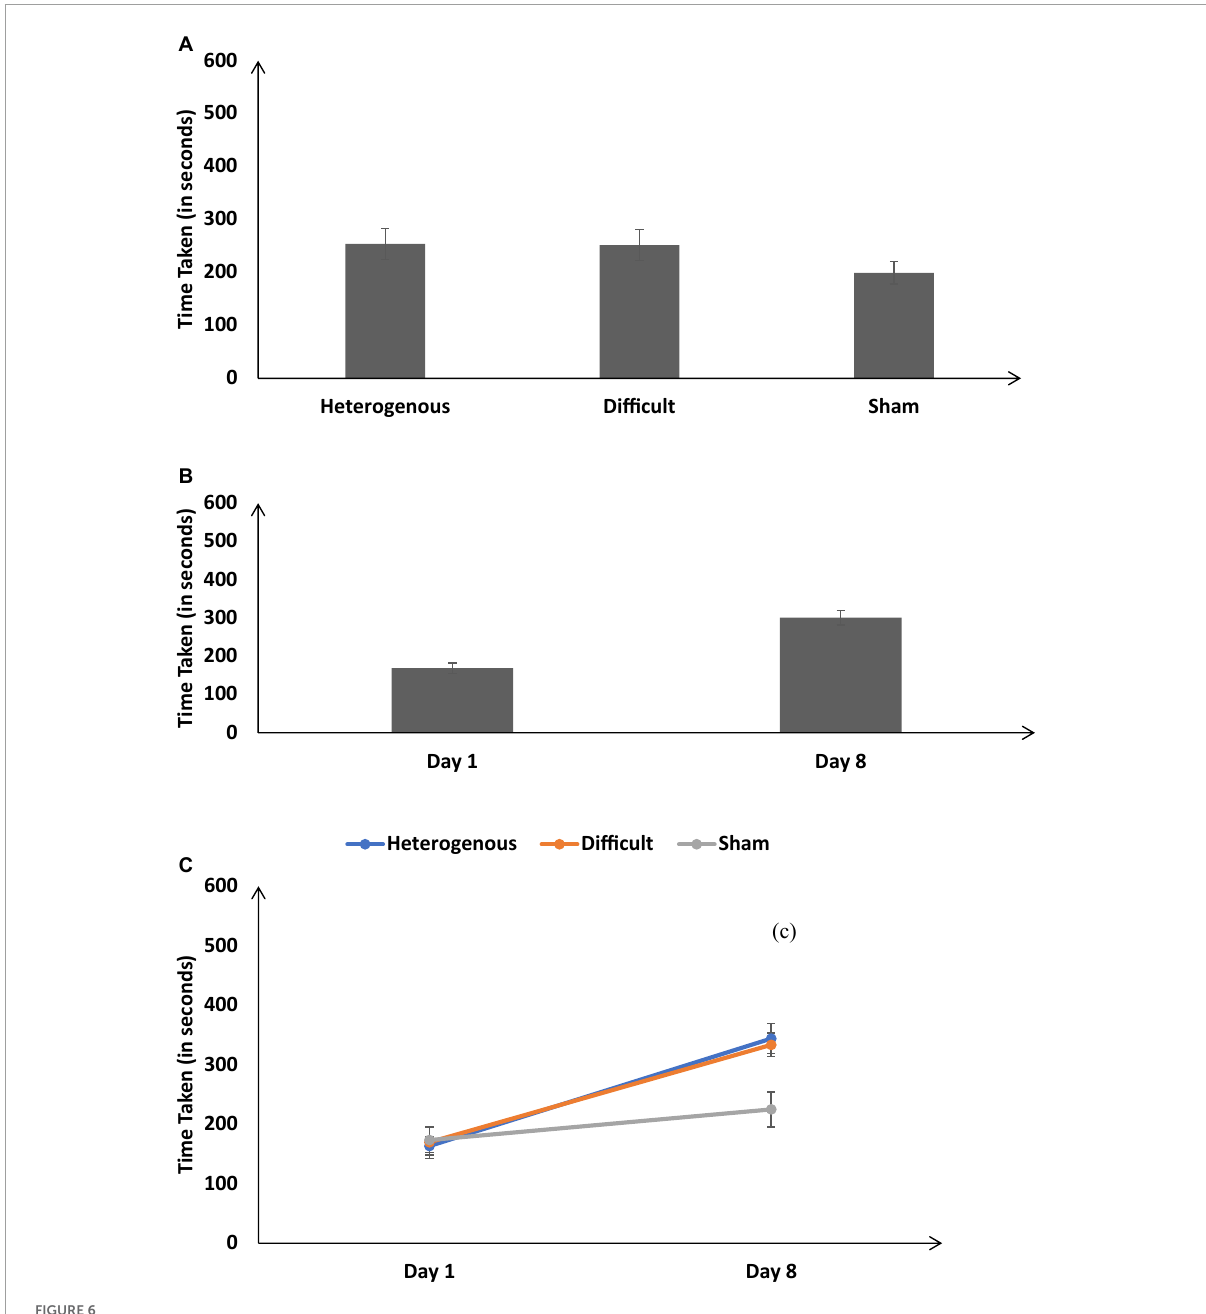
FIGURE6 (A) The time taken (in seconds) across different training conditions. (B) The time taken (in seconds) on Day 1 and Day 8. (C) The time taken (in seconds) across different training conditions on Day 1 and Day 8. The error bars show 95% CI around point